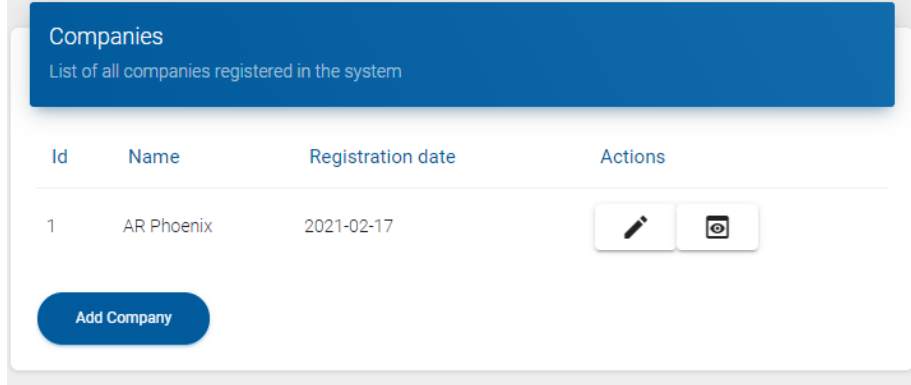
Figure 5. Companies list.